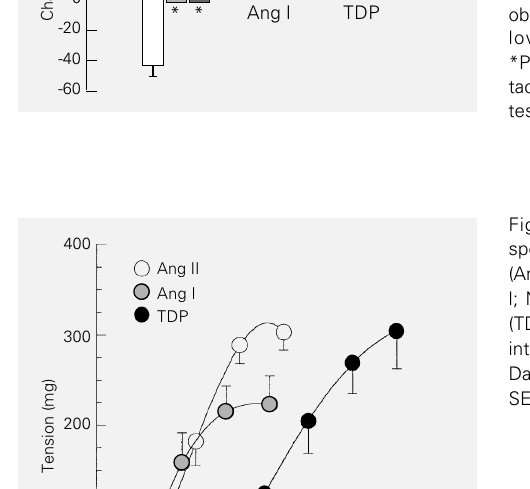
Intact endothelium Disrupted endothelium Disrupted endothelium + captopril